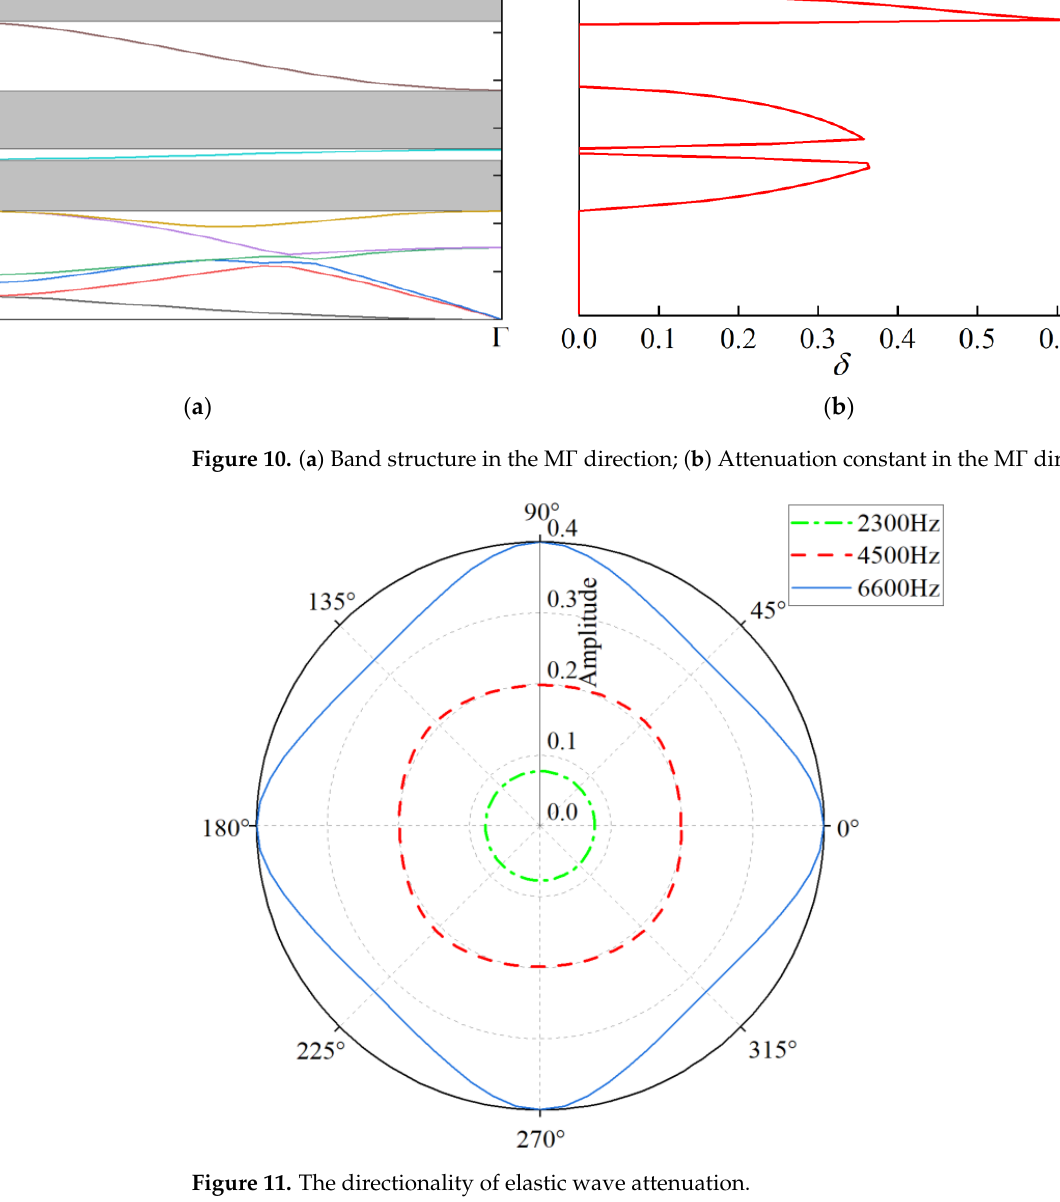
Figure 11. The directionality of elastic wave attenuation.